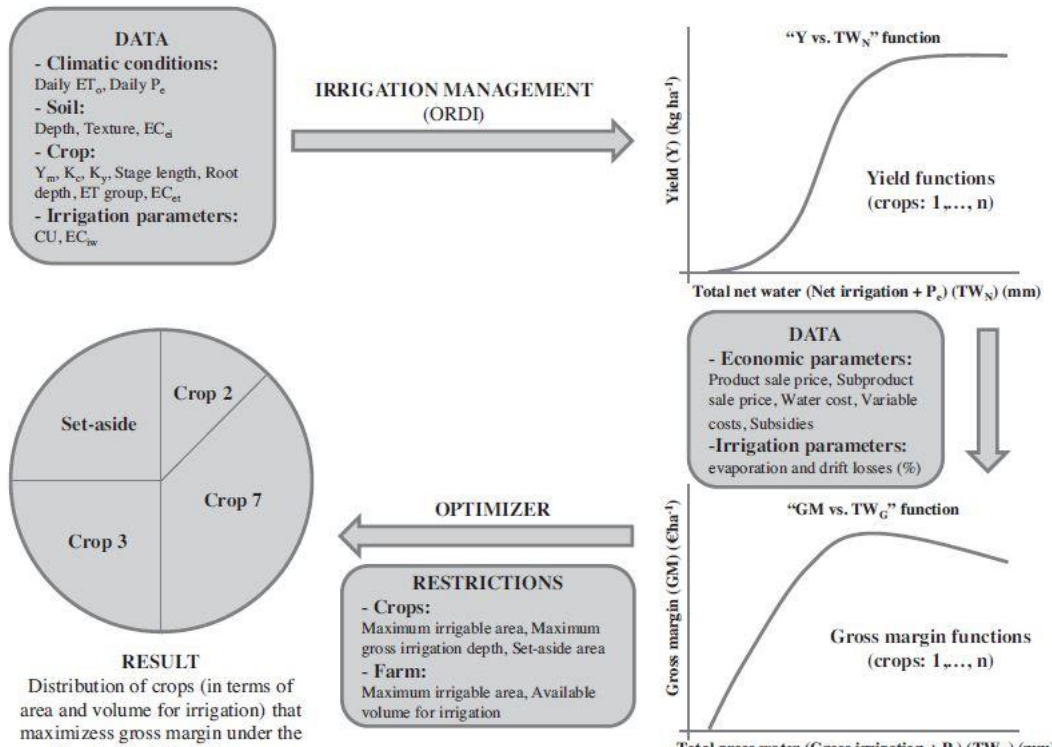
Figure 2. ETo: daily reference evapotranspiration (mm); Pe: daily effective rainfall (mm); ECei: water conductivity of the saturated soil extract at the beginning of the irrigation season (dS m − 1 ); Ym: potential yield of the crop in the area (kg ha − 1 ); Kc: crop coefficient (dimensionless) [28]; Ky: crop yield response factor by growing stage (dimensionless) [29]; ECet: water conductivity of the saturated soil extract that decreases the evapotranspiration capacity of a crop (dS m − 1 ); ET group: this conditions the daily value of the fraction of the total available water (TAW) that a crop can extract without suffering water stress [30]; CU: uniformity coefficient of the irrigation system; and ECiw: electrical conductivity of the irrigation water in the area (dS m −1 ).